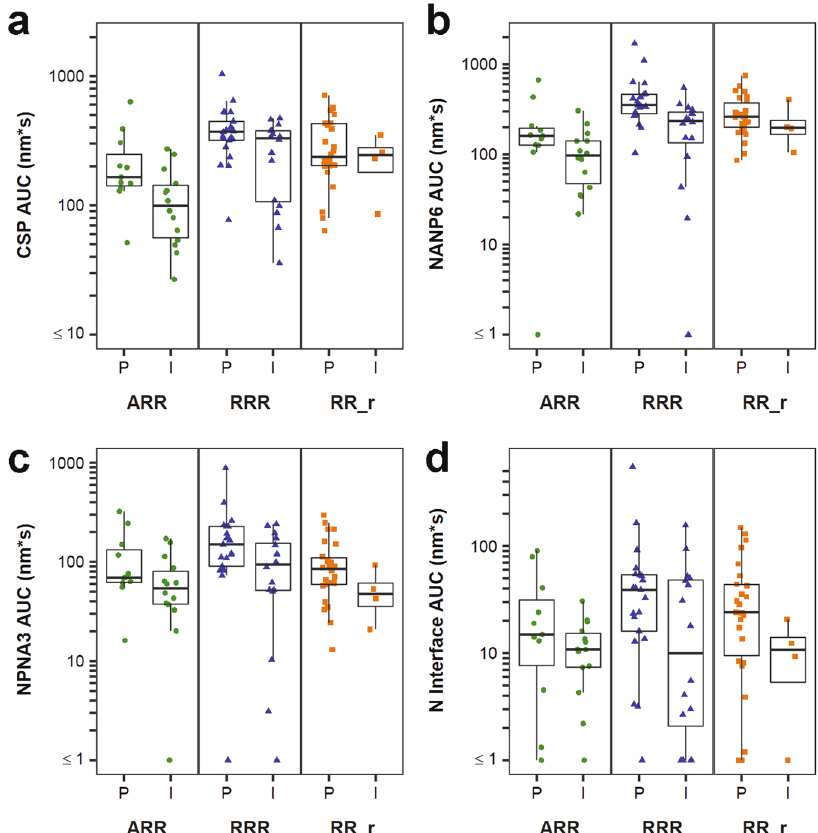
Fig. 4 Four total serum antibody measurements individually associate with protection from sporozoite infection across RTS,S/ AS01 studies. Antibody responses were compared on the day of challenge (DOC) for the protected (P) and infected (I) groups of RTS,S/AS01 vaccinees from the Ad35.CS.01 prime (ARR, green circles), standard dose (RRR, blue triangles), and delayed fractional dose (RR_r, orange squares) regimens from two different Phase 2a studies. The top total serum antibody measurements identi fi ed were CSP ( a , p = 0.003 and FDR-adjusted p = 0.034), NANP6 ( b p = 0.021 and FDR-adjusted p = 0.091), NPNA3 ( c , p = 0.025 and p -adjusted = 0.091), and N-interface ( d , p = 0.016 and FDR-adjusted p = 0.091) speci fi c serum antibody AUC diss . N = 25 for MAL-068 ARR, N = 21 for MAL-068 RRR, N = 16 for MAL- 071 RRR, and N = 30 for MAL-071 RR_r. Data shown for MAL-071 were previously reported and are displayed here in combination with MAL- 068 32 . The lower and upper hinges of the boxplots correspond to the 25th and 75th percentiles, with a line at the median. The lower and upper whisker extends from the box hinges to the smallest and largest values, respectively, which are within 1.5 * IQR of the hinge (where IQR, the inter-quartile range, is equal to the distance between the 25th and 75th